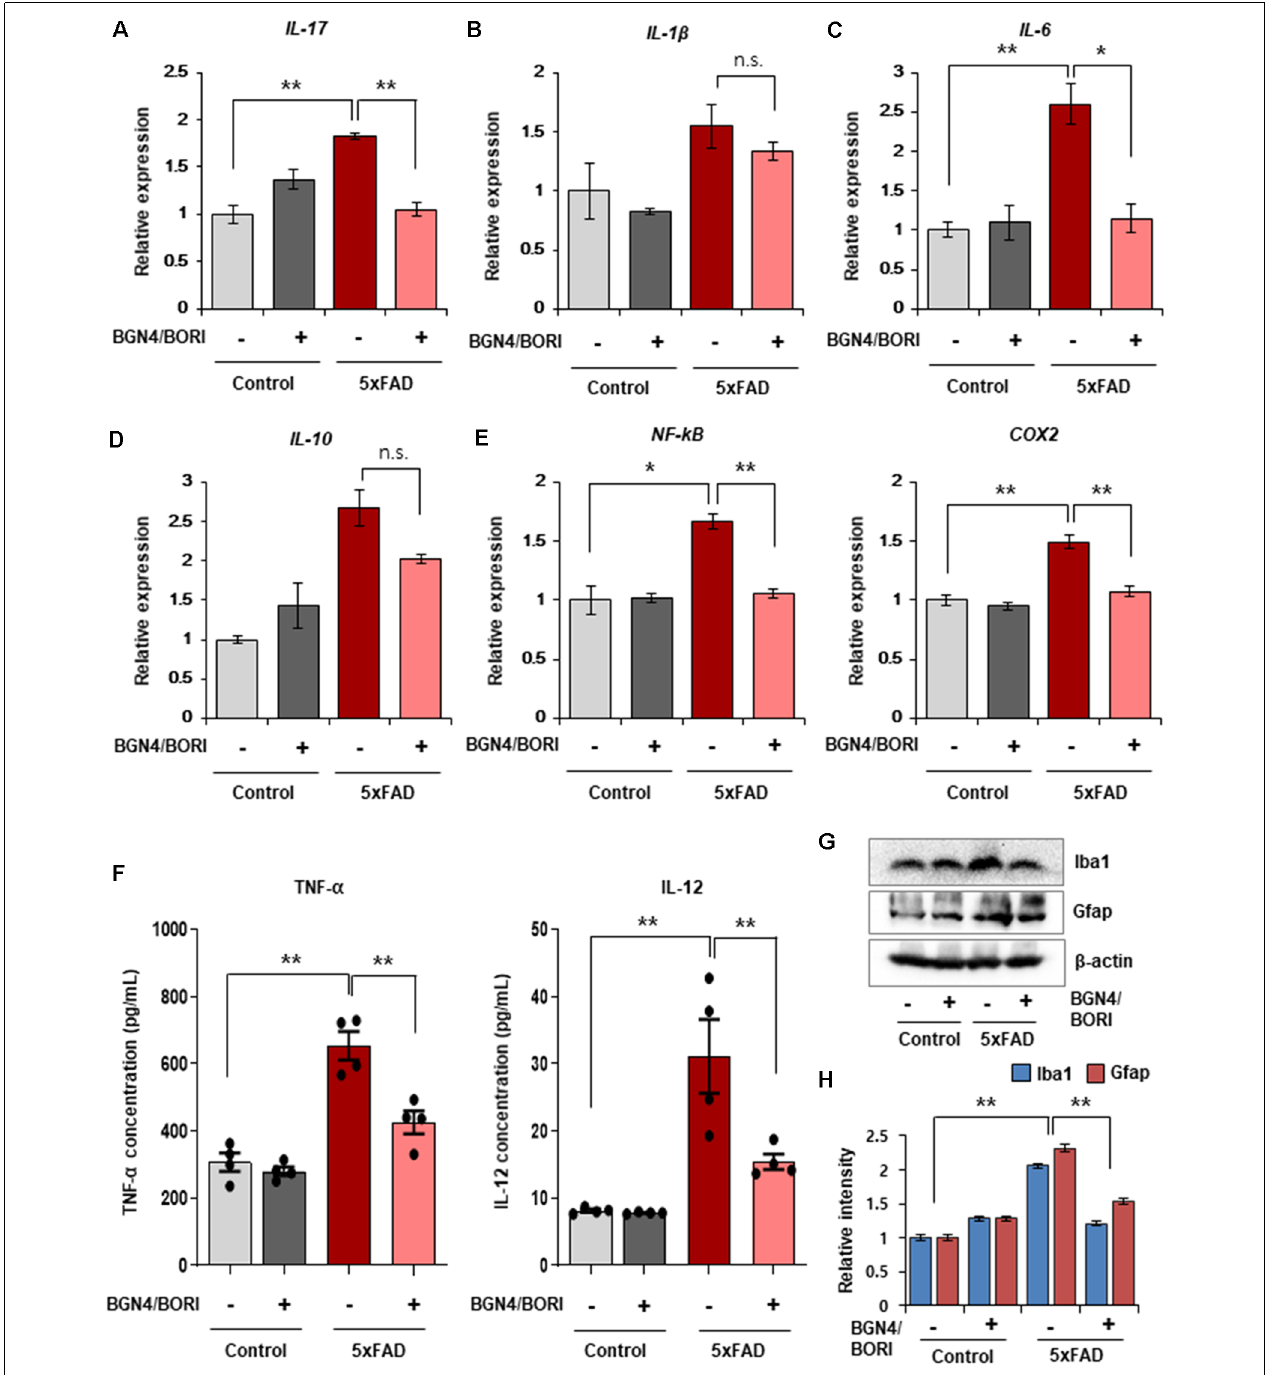
FIGURE 3 | Effects of B. bifidum BGN4 and B. longum BORI on the neuroinflammatory responses in 5xFAD Mice. (A–C) Quantitative RT-PCR analysis of the pro-inflammatory cytokines, IL-17 (A) , IL-1 β (B) , and IL-6 (C) in the hippocampus of control and 5xFAD mice treated with B. bifidum BGN4 and B. longum BORI (BGN4/BORI). Data represent the mean ± SEM. ANOVA , * p < 0.05, ** p < 0.01; n.s., not significant ( n = 5). (D) Quantitative RT-PCR analysis of the anti-inflammatory cytokine, IL-10 , in the hippocampus of control or 5xFAD mice treated with B. bifidum BGN4 and B. longum BORI. Data represent the mean ± SEM, n.s., not significant ( n = 5). (E) Quantitative RT-PCR analysis of inflammation pathway genes, NF-kB and COX2 , in the hippocampus of control or 5xFAD mice treated with B. bifidum BGN4 and B. longum BORI. Data represent the mean ± SEM. ANOVA , * p < 0.05, ** p < 0.01 ( n = 5). (F) The concentration of TNF- α and IL-12 in the serum of control or 5xFAD mice treated with B. bifidum BGN4 and B. longum BORI. Data represent the mean ± SEM. ANOVA , ** p < 0.01 ( n = 4). (G) Immunodetection of Iba1 and Gfap in Western blots with protein lysates derived from the hippocampus. (H) Hippocampal quantification of Iba1 and Gfap expression were normalized to β -actin. Data represent the mean ± SEM. ANOVA , ** p < 0.01 ( n = 5).